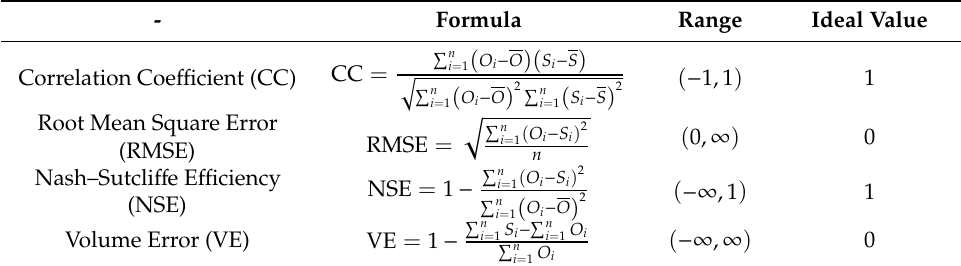
Table 3. Statistical measures used to evaluate model performance.